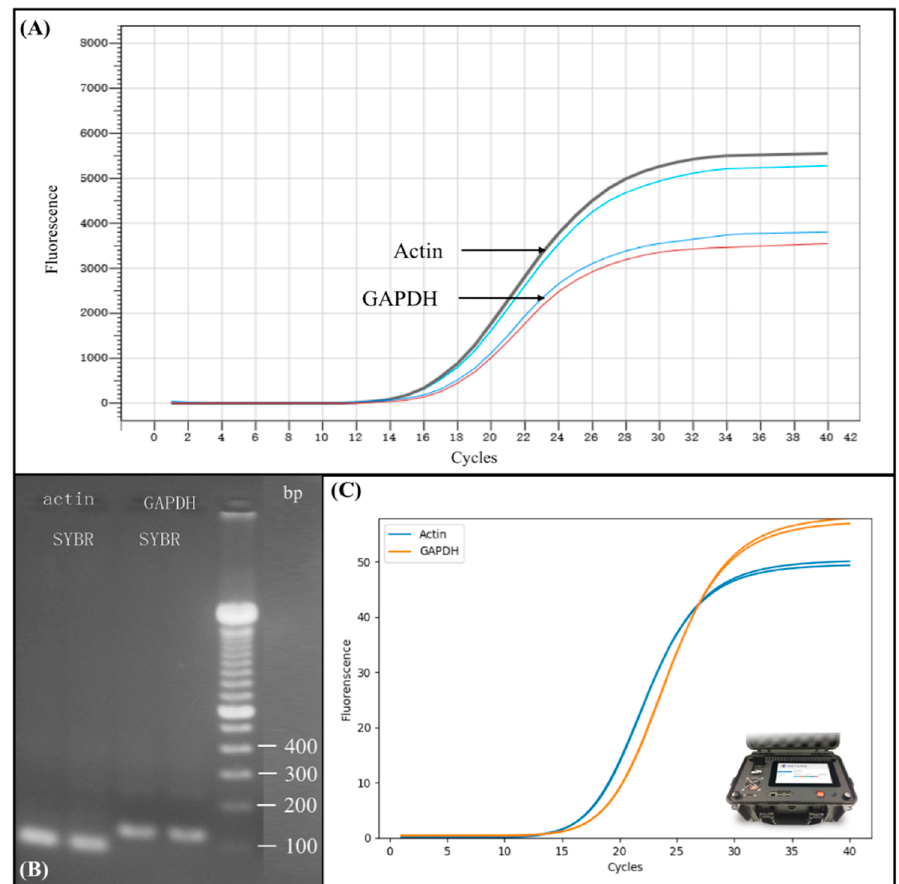
Figure 5. Verification of real-time polymerase chain reaction (PCR) results using total RNA extracted from 293T cells using automated miniaturized nucleic acid sample preparation device. ( A ) Real-time PCR amplification results on commercial real-time PCR instrument (BIOER) of Actin and GAPDH gene expression. ( B ) Electrophoresis gel separation and detection of Actin and GAPDH gene expression as a successful amplification result verification. ( C ) Comparable real-time PCR amplification results on portable microchip real-time PCR instrument using the same sample and